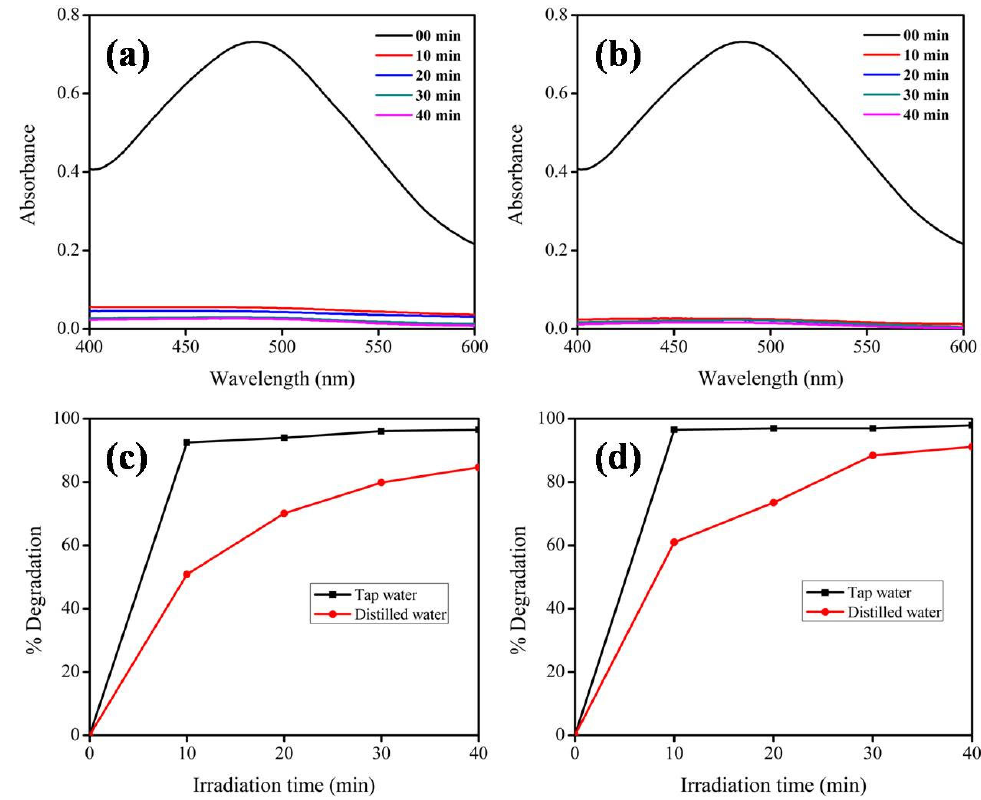
Figure 2. U.V./Vis spectra of methyl red dye in TW before and after reaction using ( a ) Fe 3 O 4 NPs, ( b ) Fe 3 O 4 /ZrO 2 NPs, ( c ) %degradation comparison of methyl red dye in distilled and TW photode ‐ graded by Fe 3 O 4 NPs, and ( d ) %degradation comparison of methyl red dye in distilled and TW photodegraded by Fe 3 O 4 /ZrO 2 NPs [71]. Table 1. Effect of tap water on photodegradation of